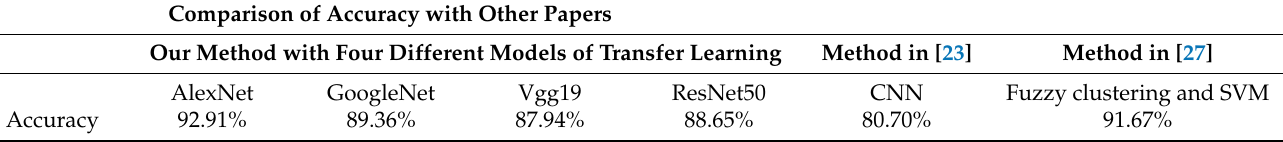
Table 11. Comparison of accuracy with other papers. Comparison of Accuracy with Other